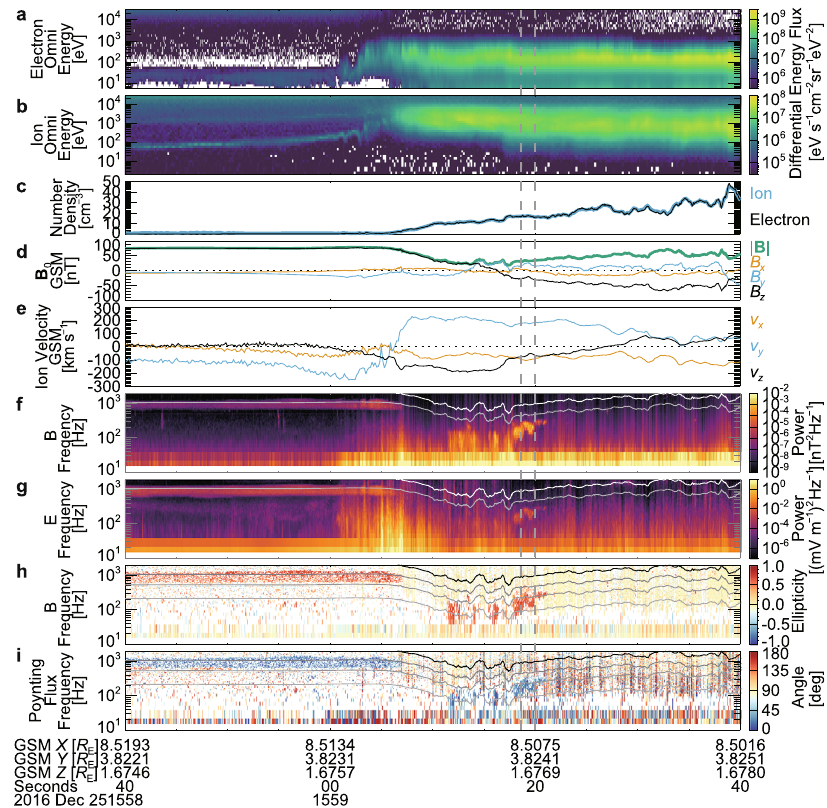
Fig. 1 | Overview of MMS1 burst data (Event 1). a Omni-directional energy spec- (darkgrey),0.25 f ce (grey),and0.1 f ce (lightgrey).Enhancementsofelectromagnetic trum of electrons (photoelectrons were subtracted). b Omni-directional energy right-hand polarized (positive ellipticity) waves corresponds to whistler-mode spectrum of ions. c Number density of ions (light blue) and electrons (black). waves. Vertical grey dashed lines indicate the interval shown in Fig. 4. Spacecraft d , e thebackgroundmagnetic fi eld( B 0 )andionbulkvelocityinthegeocentricsolar positions in Earth radii ( R E ) are shown at the bottom. MMS crossed the magneto- magnetic (GSM) coordinates. f , g Wave power spectrum of magnetic and electric pause southward of the reconnection site from the magnetosphere to the mag- f fi elds with the cyclotron resonance velocity ( f netosheath (see also Fig. ce ) (white) and 0.5 ce (grey). h , i Spectra of ellipticity and angle of Poynting fl ux from B 0 with f ce (black), 0.5 f ce